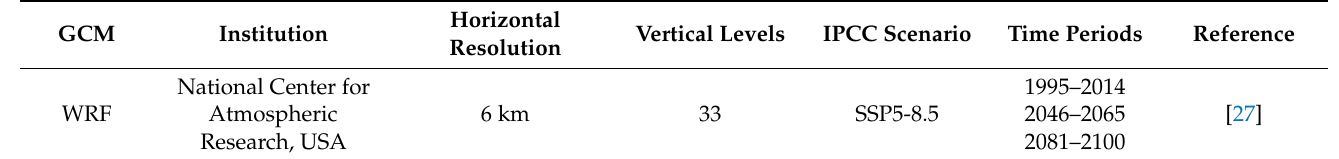
Table 2. WRF regional simulation: institution, horizontal and vertical resolutions, IPCC scenarios, time periods considered, and relevant